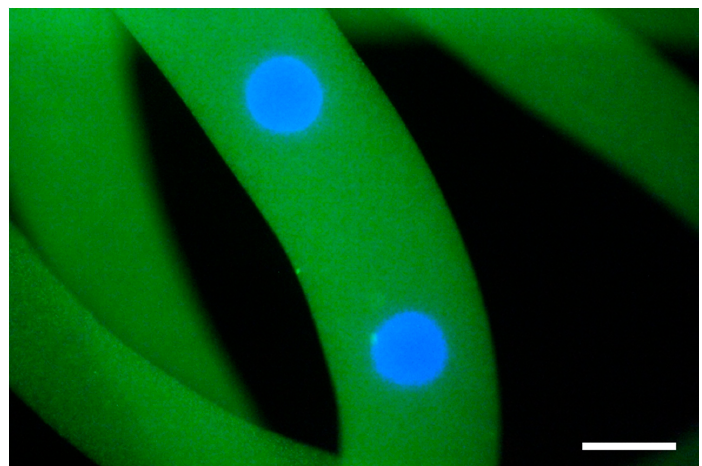
Figure 5. Merged fluorescent micrograph of the Ca-alginate hydrogel fiber containing gelatin microspheres colored with blue and green fluorescent particles. Scale bar, 400 μ m.